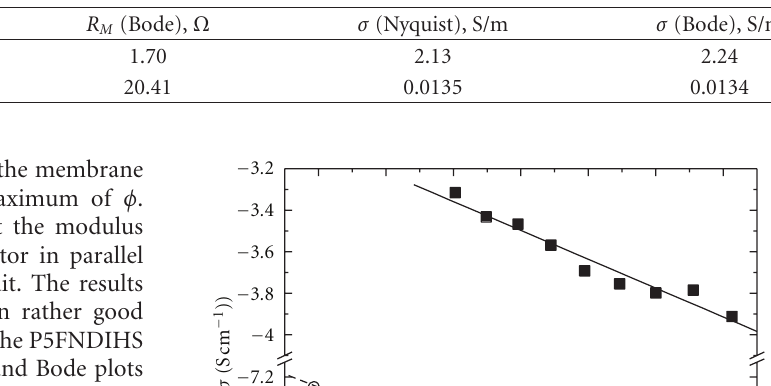
Table 2: Comparative and illustrative results for the ohmic resistance, R M , and conductivity, σ , of the membranes at 30 ◦ C obtained from Nyquist and Bode diagrams.